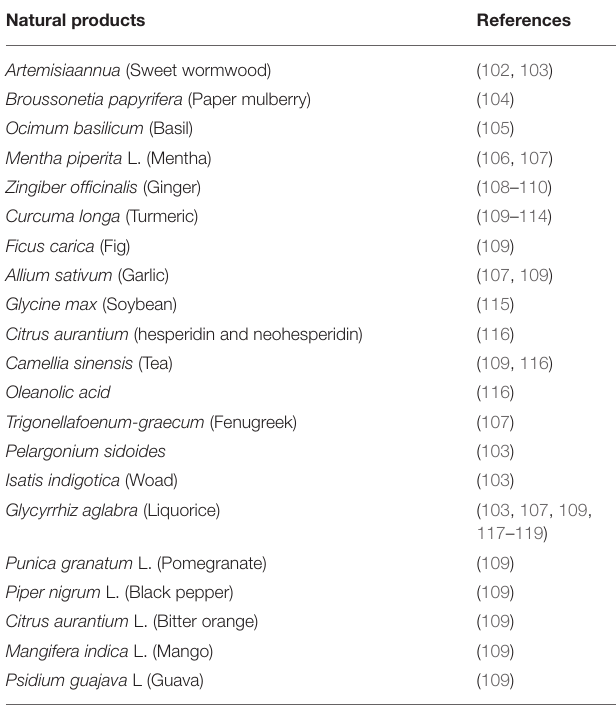
immunomodulatory, and antiviral activities that could have anti-SARS-Co-2 activity. Natural